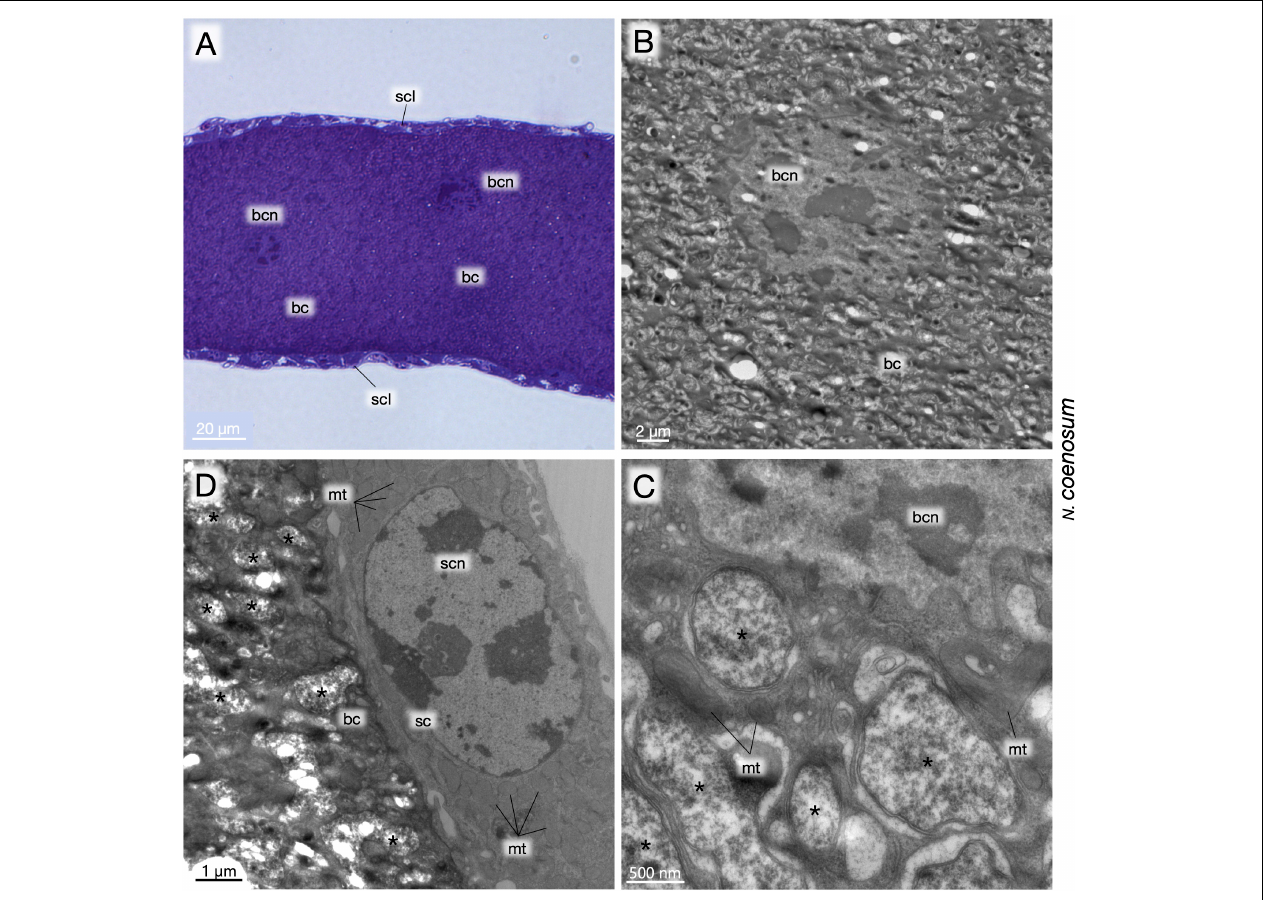
FIGURE 5 | Fine structure of larval bacteriomes, bacteriocytes and endosymbiotic bacteria of N. coenosum . (A) Semi-ultrathin section of a bacteriome stained with toluidine blue. Voluminous bacteriocytes full of endosymbiotic bacteria are surrounded by a thin sheath cell layer on the surface. (B) TEM image of a bacteriocyte, whose cytoplasm exhibits bizarre cytological features such as degenerate cytology, vacuolization, deformed endosymbiont cells, etc. (C) Magnified TEM image of the cytoplasm-nucleus interface of a bacteriocyte. Pleomorphic symbiont cells are found in the cytoplasm with mitochondria and accumulated membranous elements. (D) Magnified TEM image of the periphery of a bacteriome adjacent to a sheath cell. Note that, while the bacteriocyte exhibits degenerative cytological features, the sheath cell looks normal, confirming that the degenerative cytology of the bacteriocyte is not due to histological artifacts. Asterisks indicate endosymbiont cells. bc, bacteriocyte; bcn, bacteriocyte nucleus; mt, mitochondrion; sc, sheath cell; scl, sheath cell layer; scn, sheath cell